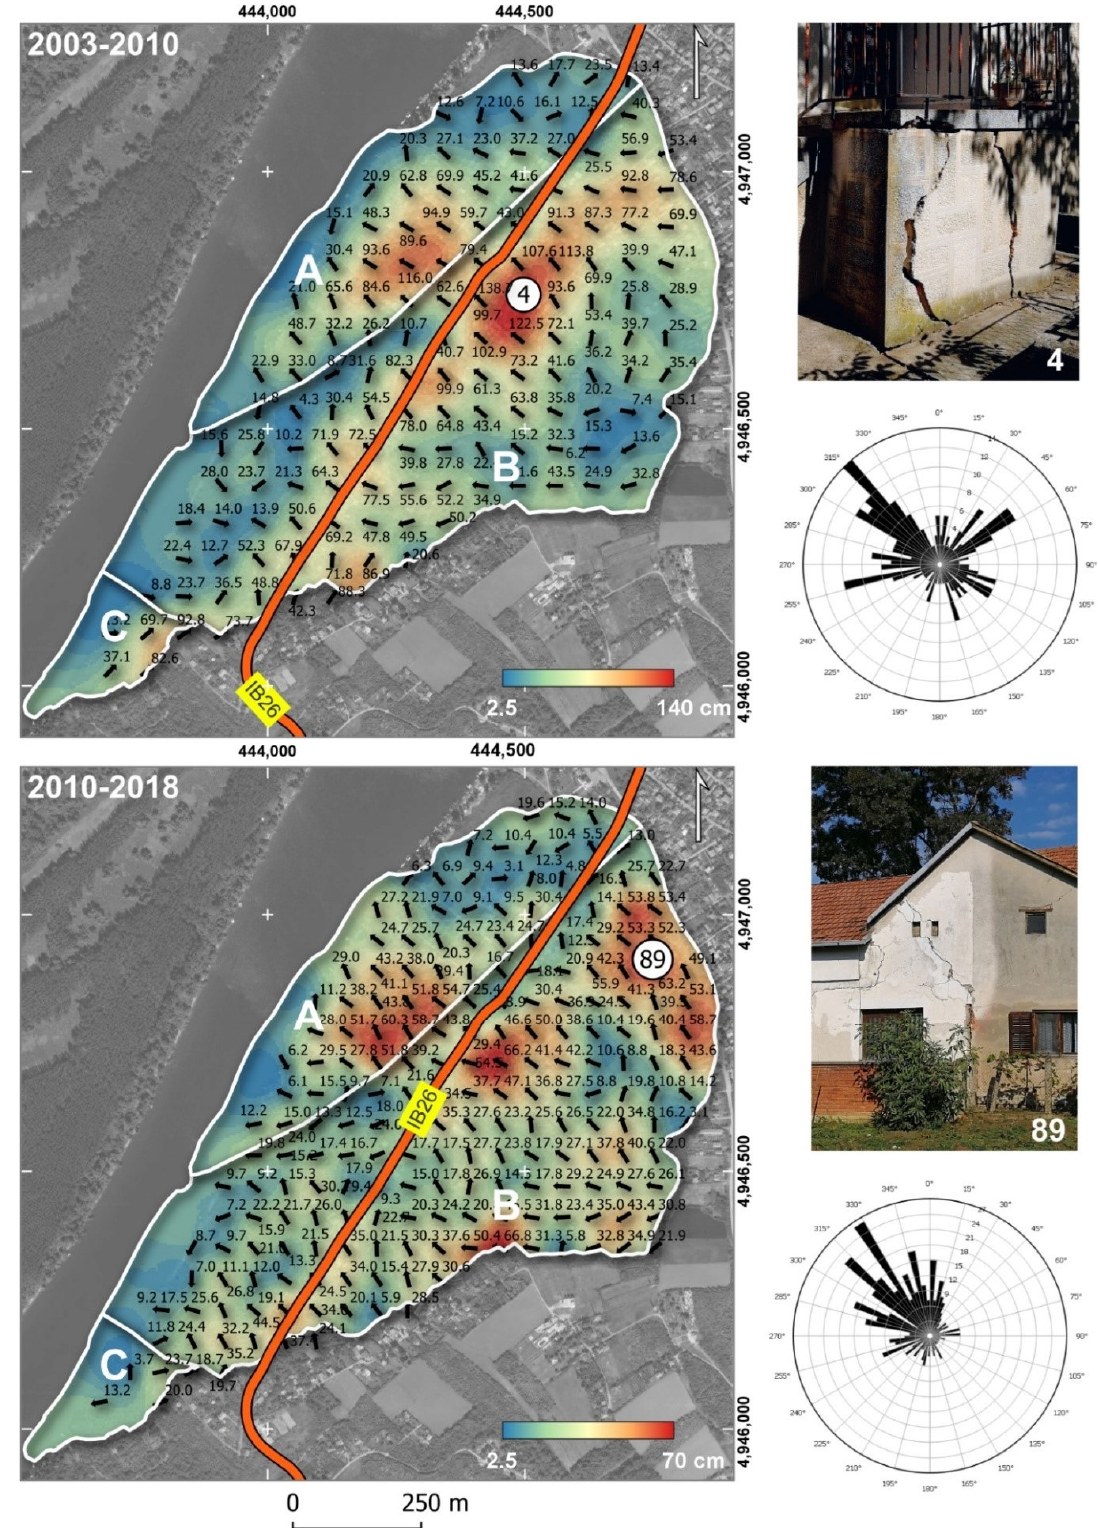
Figure 7. Display of the spatial distribution of displacement vectors obtained based on the comparison of orthophoto pairs (top—2003 and 2010, bottom 2010 and 2018) with the RBF interpolation map as a background. On the right side of both maps, one construction from the most jeopardized part is shown; the rose diagram of all displacement vectors and the layout of the blocks are modified according to Ðuri´c